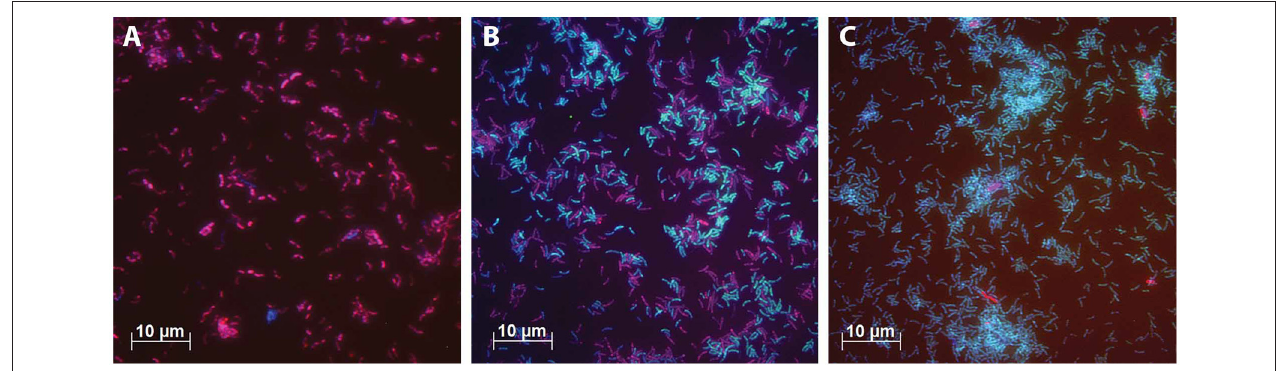
FIGURE 4 | FISH microscopic photographs of steady state cultures. The cells were stained with Cy5-labeled probes for bacteria (EUB338mix, blue), Cy3-labeled probes for Betaproteobacteria (Beta42a, red) and FLUOS-labeled probes for Deltaproteobacteria (Delta495, green). Cells that are purple indicate cells to which the probes EUB338mix and Beta42a were hybridized. Cells that are light blue indicate cells to which the probes EUB338mix and Delta495 were hybridized. (A) The culture grown with Ac/N ratio of 0.66. (B) The culture grown with Ac/N ratio of 1.08. (C) The culture grown with Ac/N ratio of 1.87.